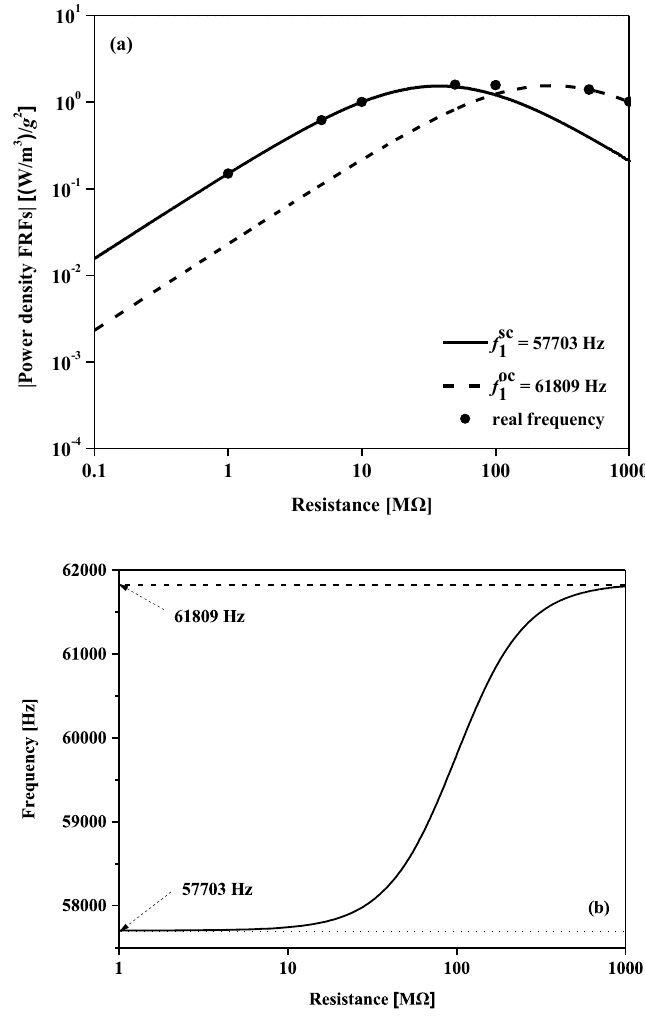
Figure 8. ( a ) Variation of the power density FRFs with load resistance for excitations at the short and open circuit resonance frequencies of the first order mode ( h = 0.3 µ m). ( b ) Variation of the optimal external frequencies with the load resistances.